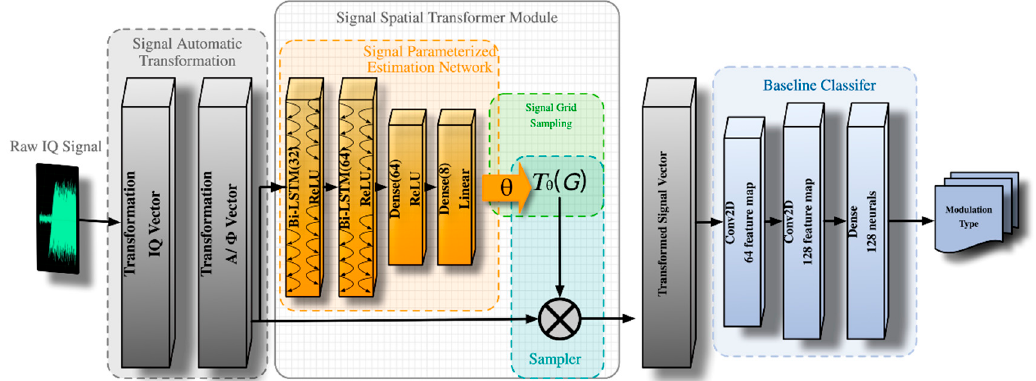
Figure 2. The framework of the proposed method with SSTM for directly using raw in-phase and quadrature (IQ) samples.